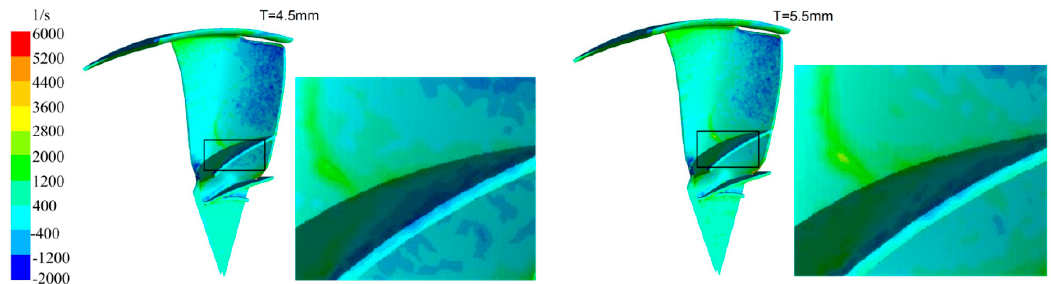
Figure 9. Distribution of CV on fan blade surface with di ff erent guiding fi n thicknesses.